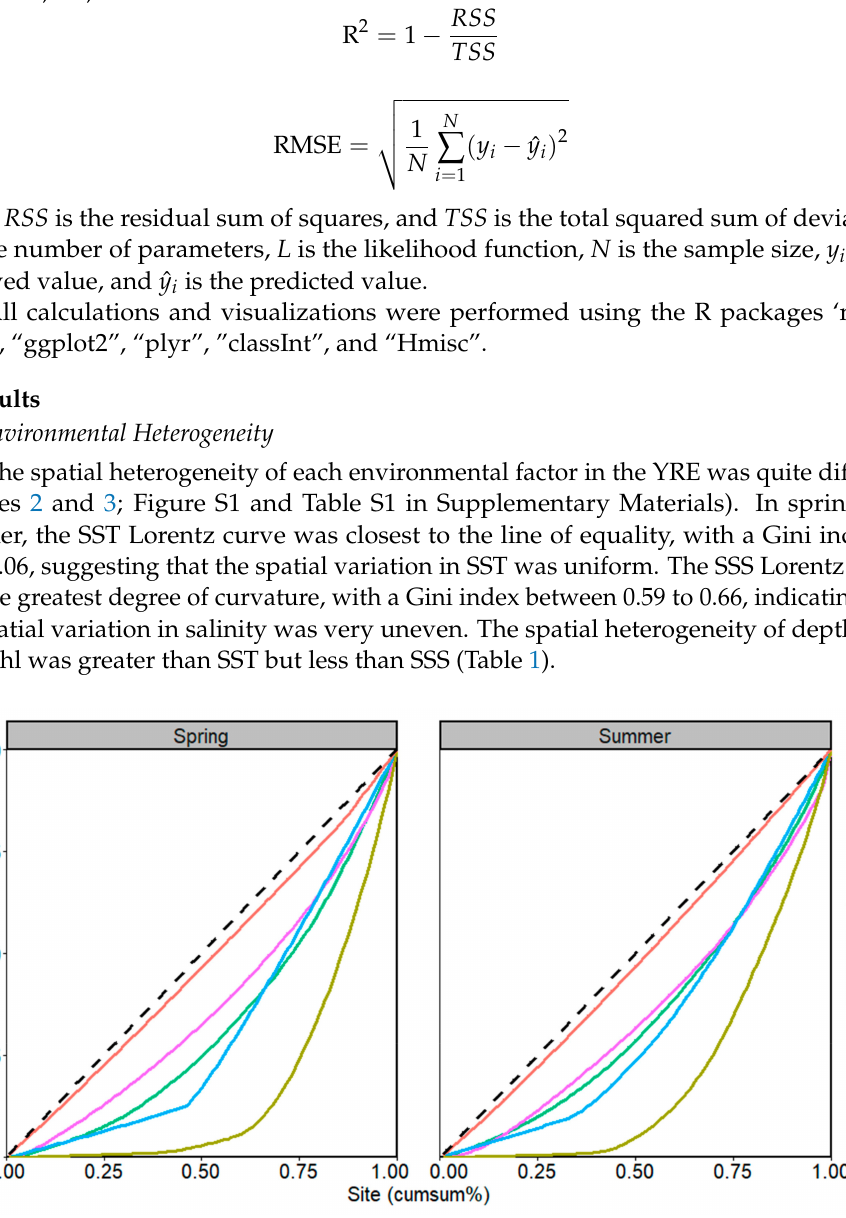
Figure 2. The Lorentz curve of environmental factors in the Yangtze Estuary in the spring and summer (2018–2020; the black dashed line represents the line of equality; the colorful lines are the Lorentz curves, the greater the curvature of the curve, the more heterogeneous the environmental factors are distributed